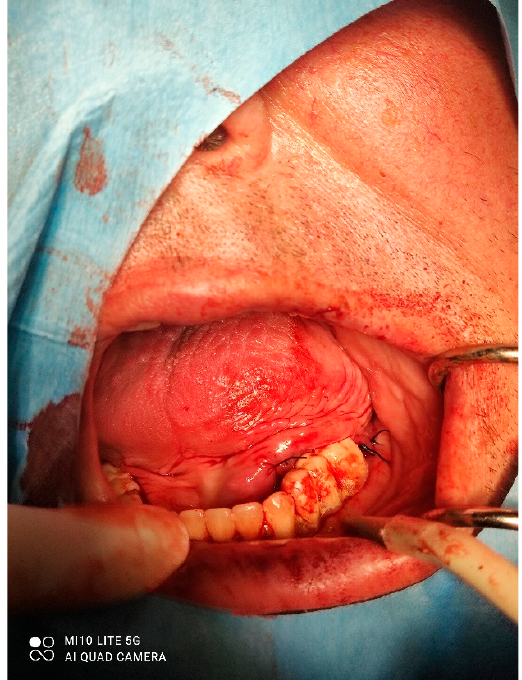
Figure 6. Right after suturing.